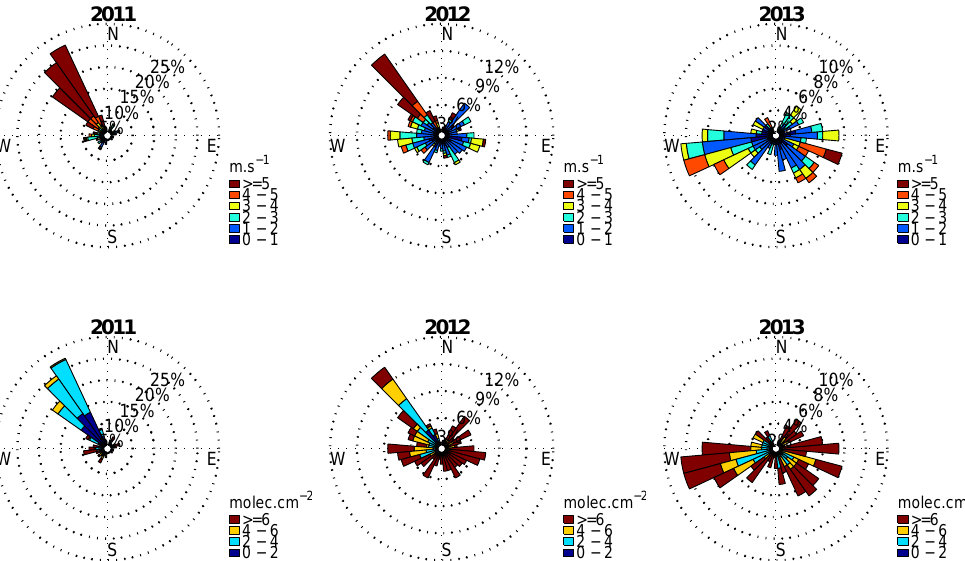
Figure 14. Wind rose for wind speed (first row; ms − 1 ) and SO 2 VCD (second row; 10 16 moleccm − 2 ) for January 2011 (first column), 2012 (second column), and 2013 (third